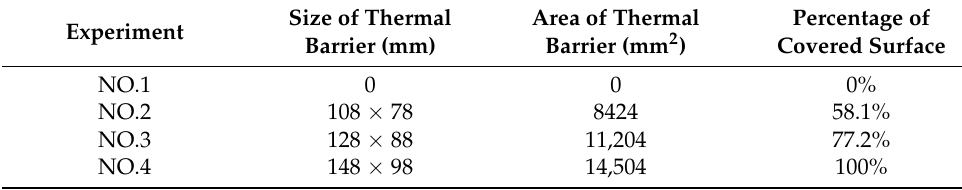
Table 3. Different areas of thermal